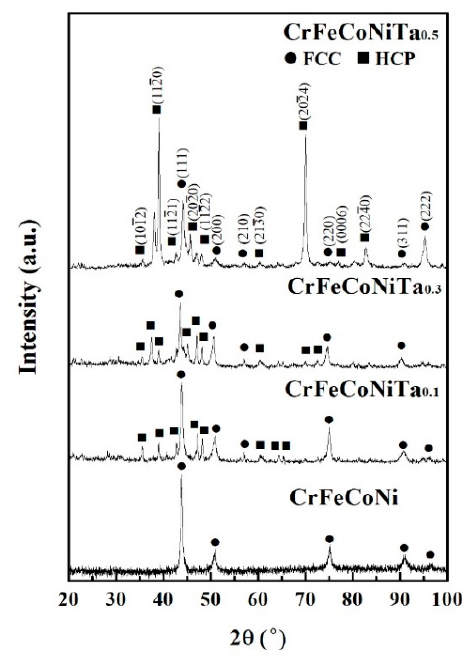
Figure 2. X-ray di ff ractometer (XRD) patterns of as-cast CoCrFeNiTa x Figure 2. X-ray diffractometer ( XRD) patterns of as-cast CoCrFeNiTa x alloys.